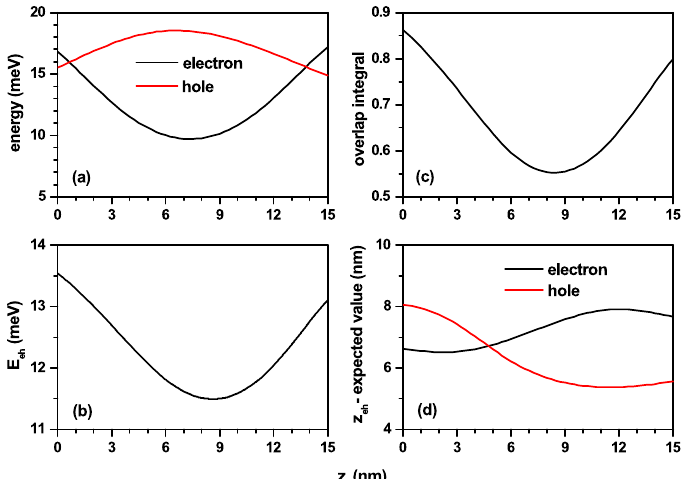
Figure 7. Characterization of the exciton effects in a truncated conical-shaped GaAs-Al 0.3 Ga 0.7 As quantum dot as a function of donor impurity position z i . ( a ) Ground state for electron and hole; ( b ) electron–hole Coulomb energy; ( c ) overlap integral; and ( d ) z expected value for each carrier. Calculations are for R 1 = 10 nm, R 2 = 20 nm, h = 15 nm, and B =